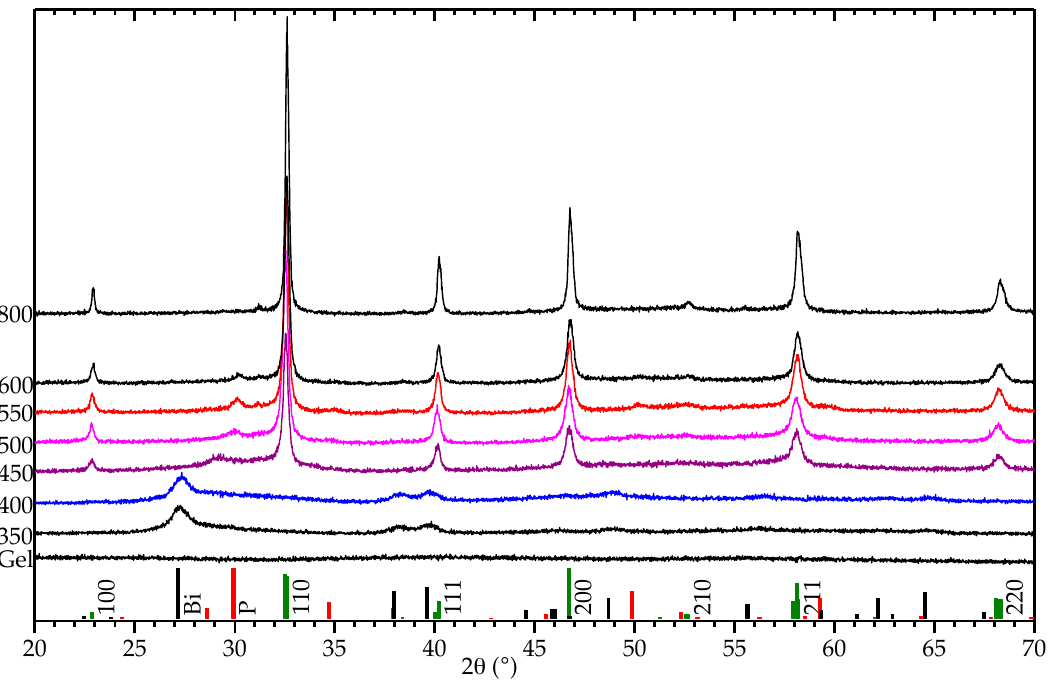
Figure A1. XRD patterns of calcined powders from nitrate method gel. All samples were calcined for 2 h